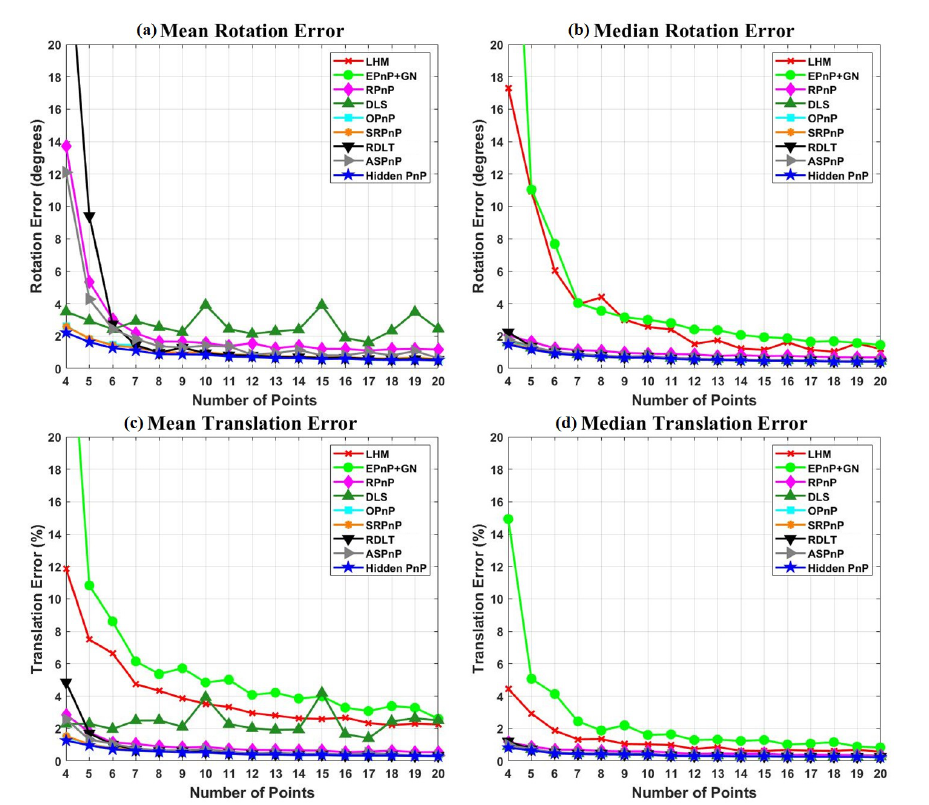
Figure 4. Error comparison in the Planar